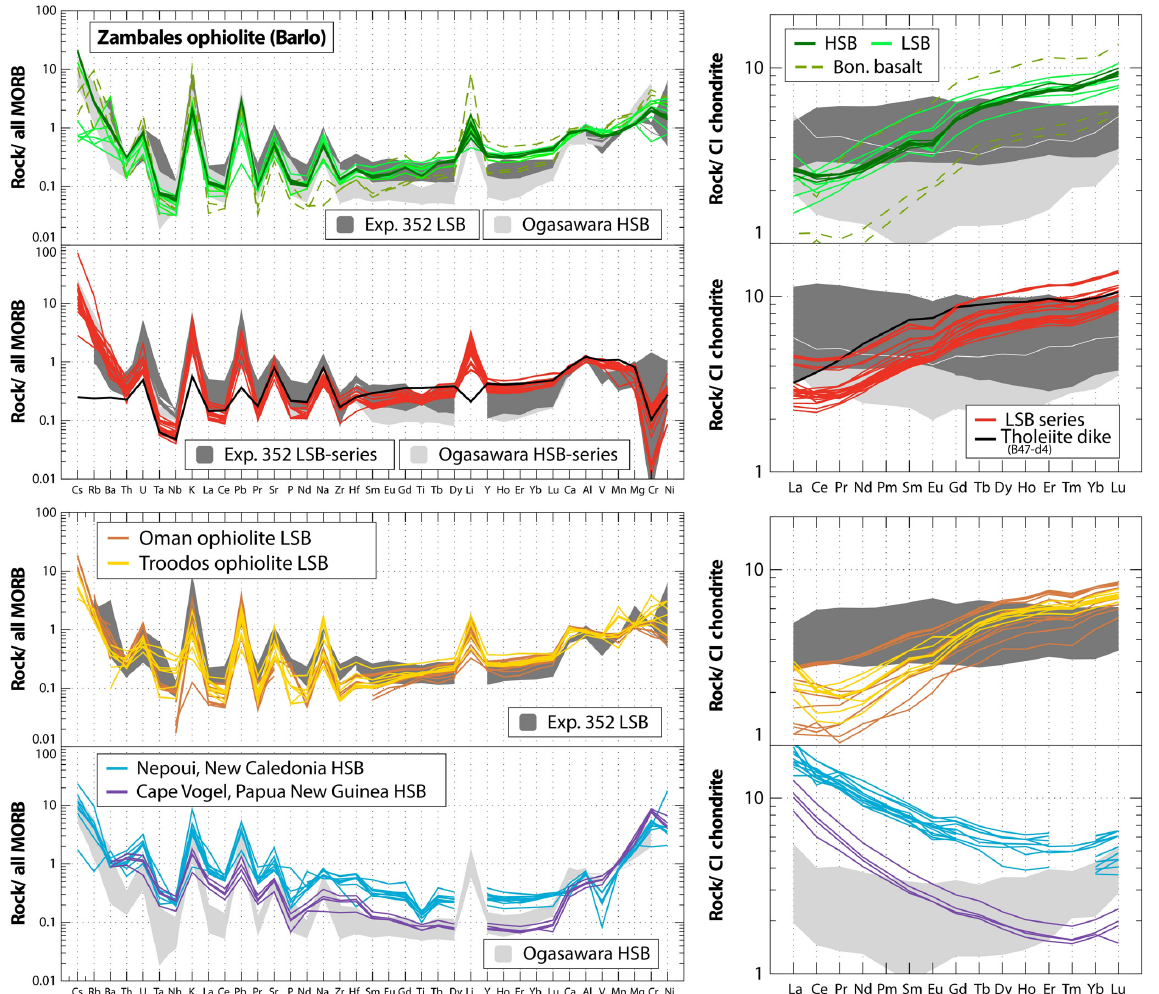
Figure 7. Extended MORB and chondrite normalized trace element patterns. Normalizing values are from Barrat et al. (2012) and Gale et al.